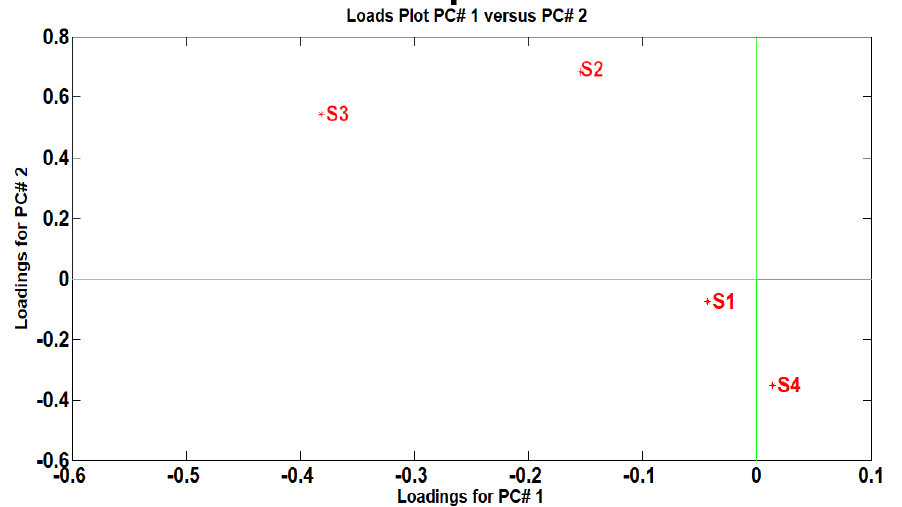
Figure 14. PCA loadings obtained from the sensors. The numbers represent the features of the different sensors.